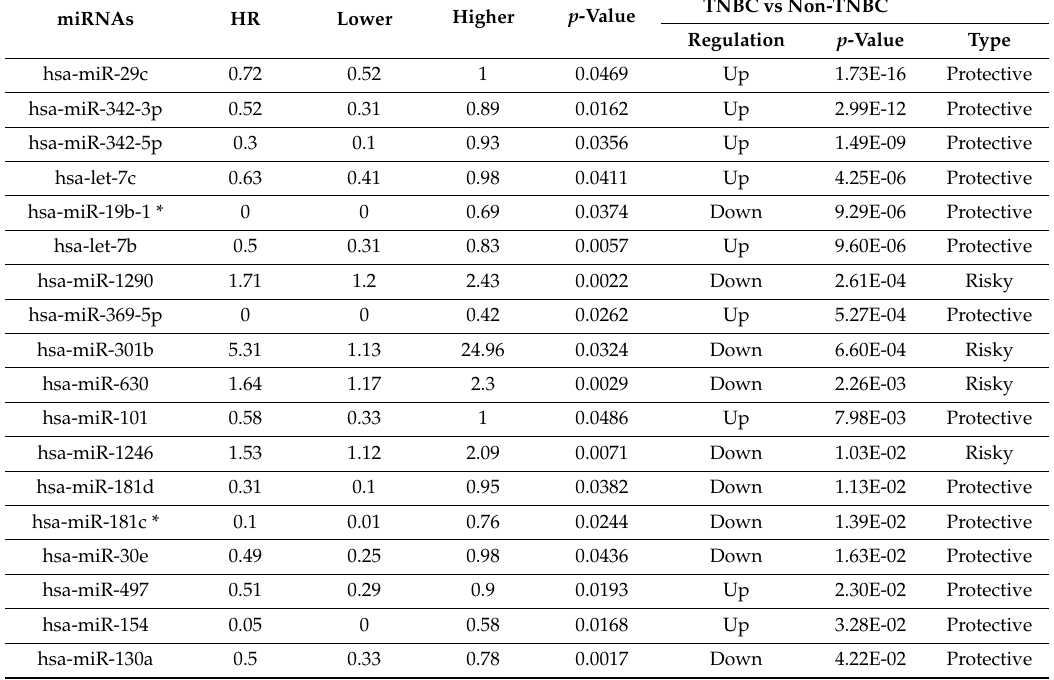
Table 1. Table showing the results of cox regression model of the miRNAs significantly associated with distance metastasis–free survival. The regulation column represents the trends of expression compare to non-TNBC